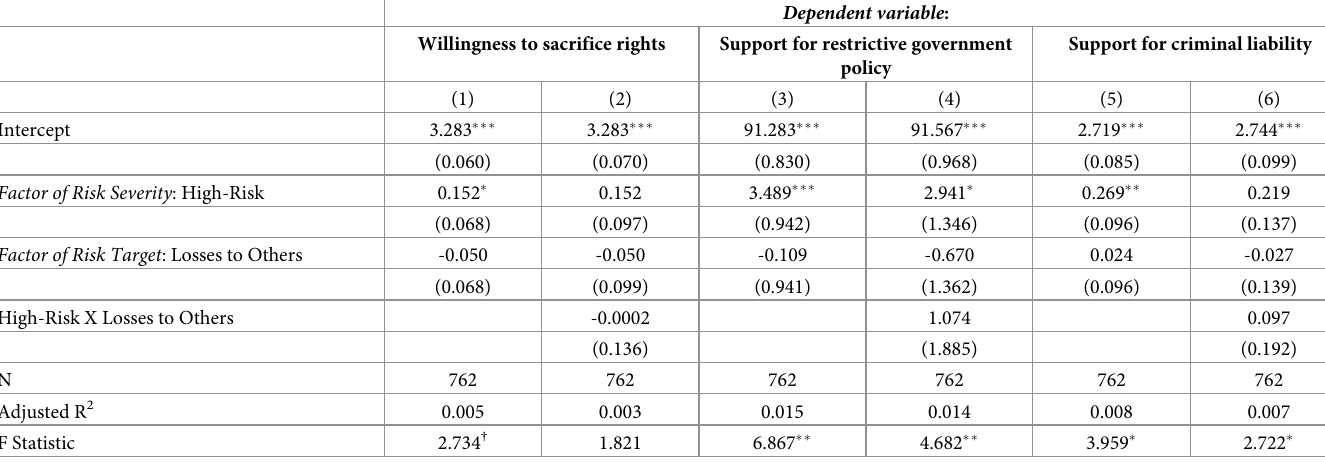
Table 4. OLS regression models estimates of main effects and interactions; pre-treatment covariates as controls are not